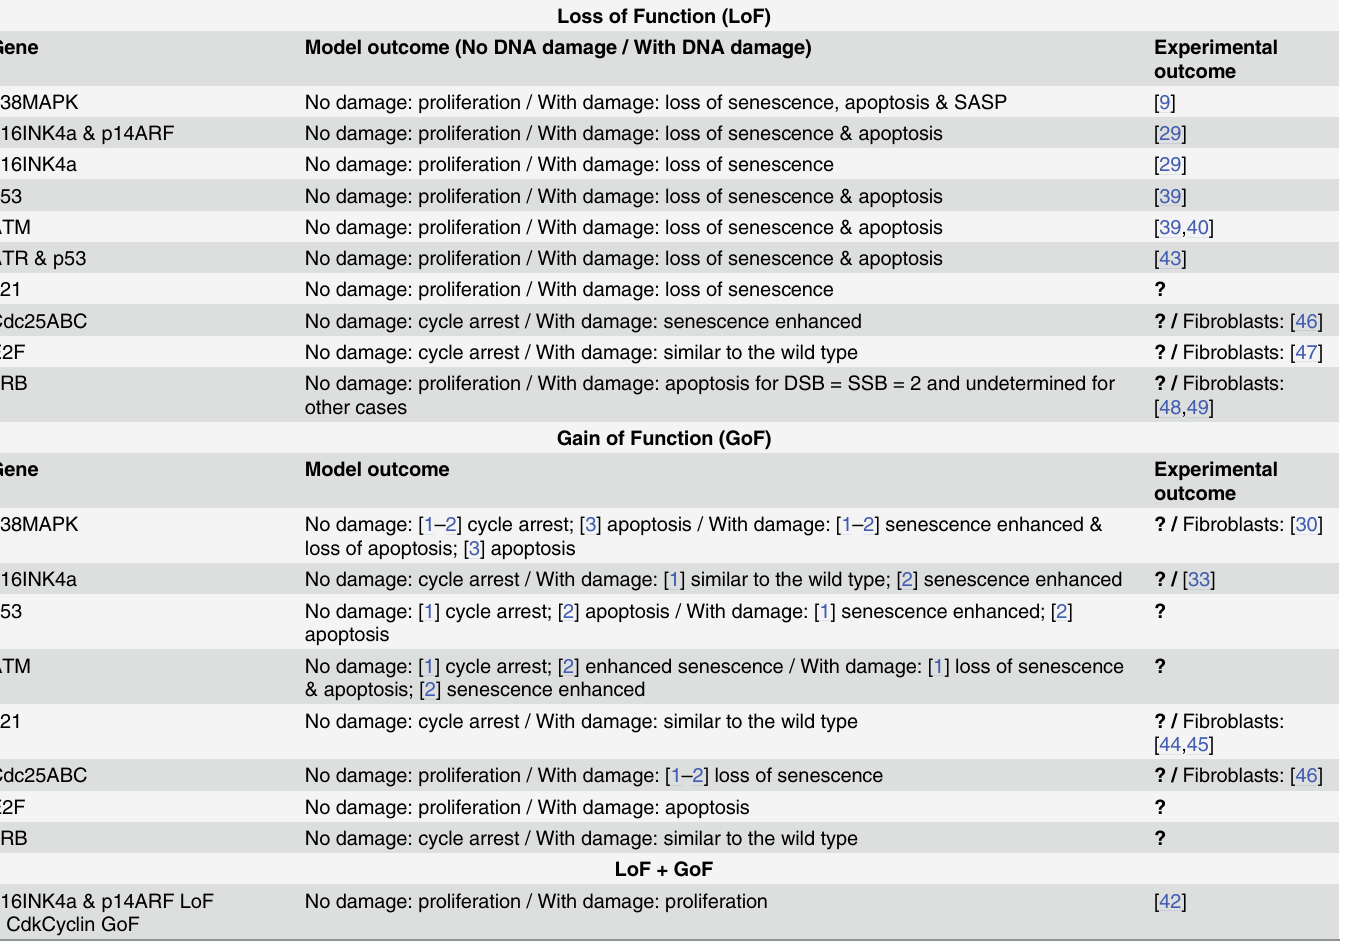
Table 3. Comparison with